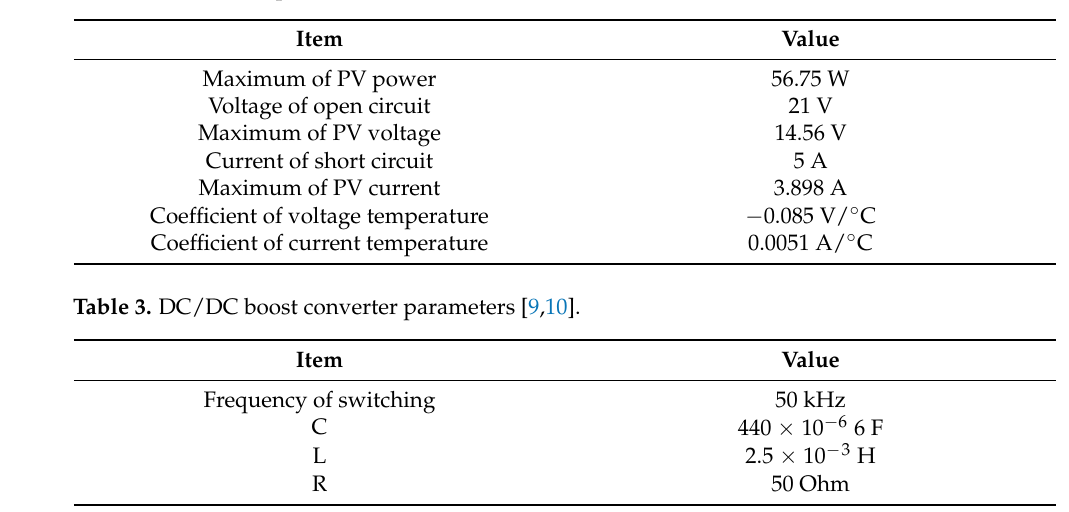
Table 2. PV module parameters [9].